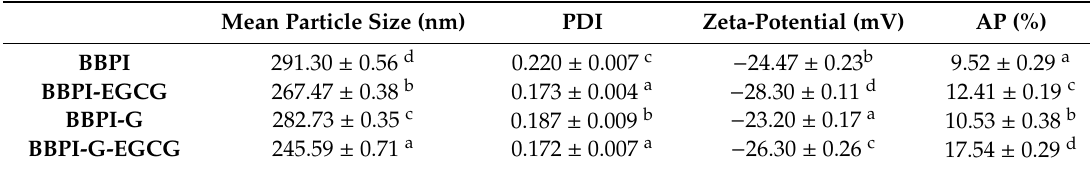
Table 2. Characteristics (mean particle size, PDI, zeta-potential and AP) of emulsions stabilized